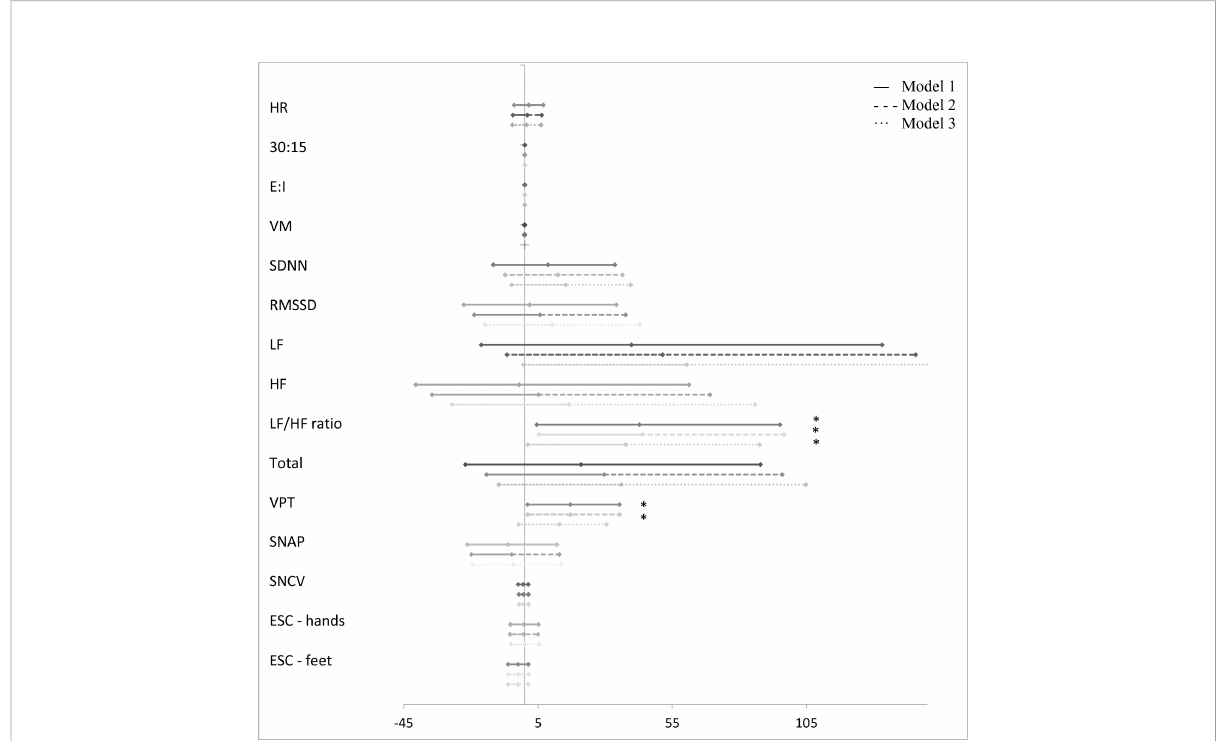
FIGURE 2 Forest plot of the associations between “ lipid peroxidation ” and measures of diabetic neuropathy. Results are presented as estimates and 95% con fi dence intervals. Estimates show the percentage change in the outcomes for an increase of one unit of “ lipid peroxidation ” . Studies with con fi dence interval crossing the vertical line are inconclusive. Model 1 adjusted for age and gender, model 2 adjusted as model 1 + diabetes duration and HbA 1c , and model 3 adjusted as model 2 + current smoking, total cholesterol, triglycerides, systolic blood pressure, and the use of beta blockers. CAN, cardiovascular autonomic neuropathy; HR, heart rate; 30:15, lying-to-standing test; E:I, deep breathing test; VM, Valsalva Manoeuvre; SDNN, standard deviation of normal-to-normal intervals; RMSSD, root mean square of the sum of the squares of differences between consecutive R-R intervals; LF, low-frequency power; HF, high-frequency power; DSPN, distal symmetric polyneuropathy; VPT, vibration perception threshold; SNAP, sural nerve amplitude potential; SNCV, sural nerve conduction velocity; ESC, electrochemical skin conduction. *p <